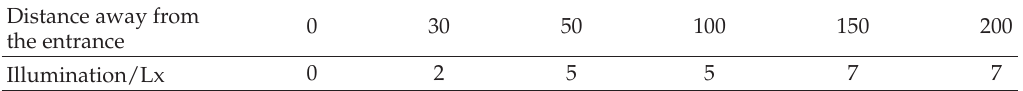
Table 3: Luminosity in entrance segment.